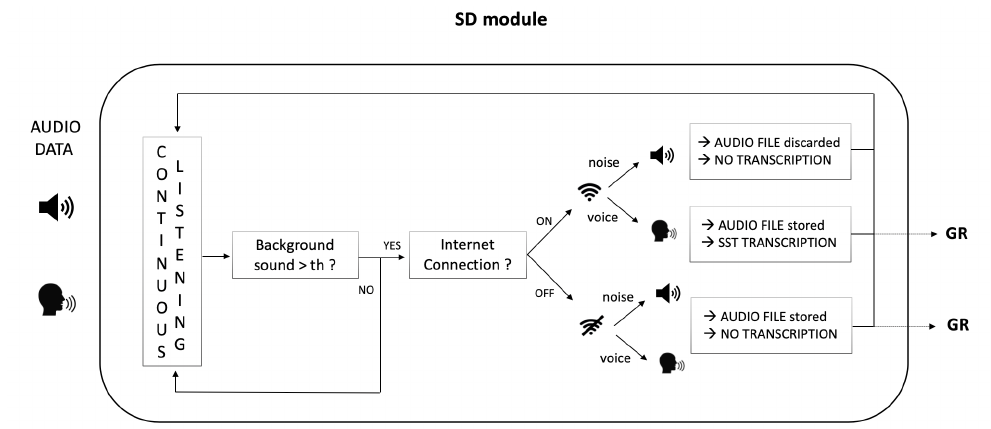
Figure 3. Speech Detector (SD) module functioning. The module continuously listens to the environ- ment through the microphone and starts to record when an energy value above a certain